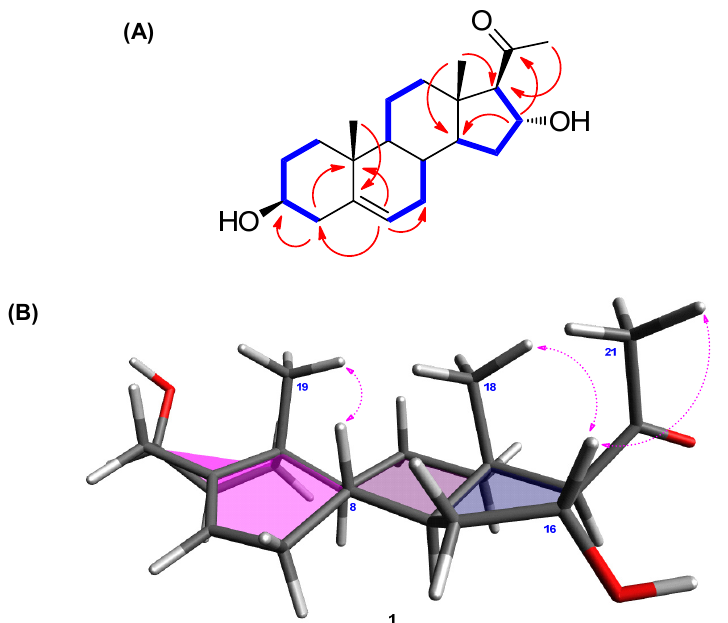
Figure 2. ( A ) 1 H- 1 H COSY (bold lines) and key HMBC (arrows) correlations of 1 . ( B ) Key NOESY (arrows) correlations of 1 .